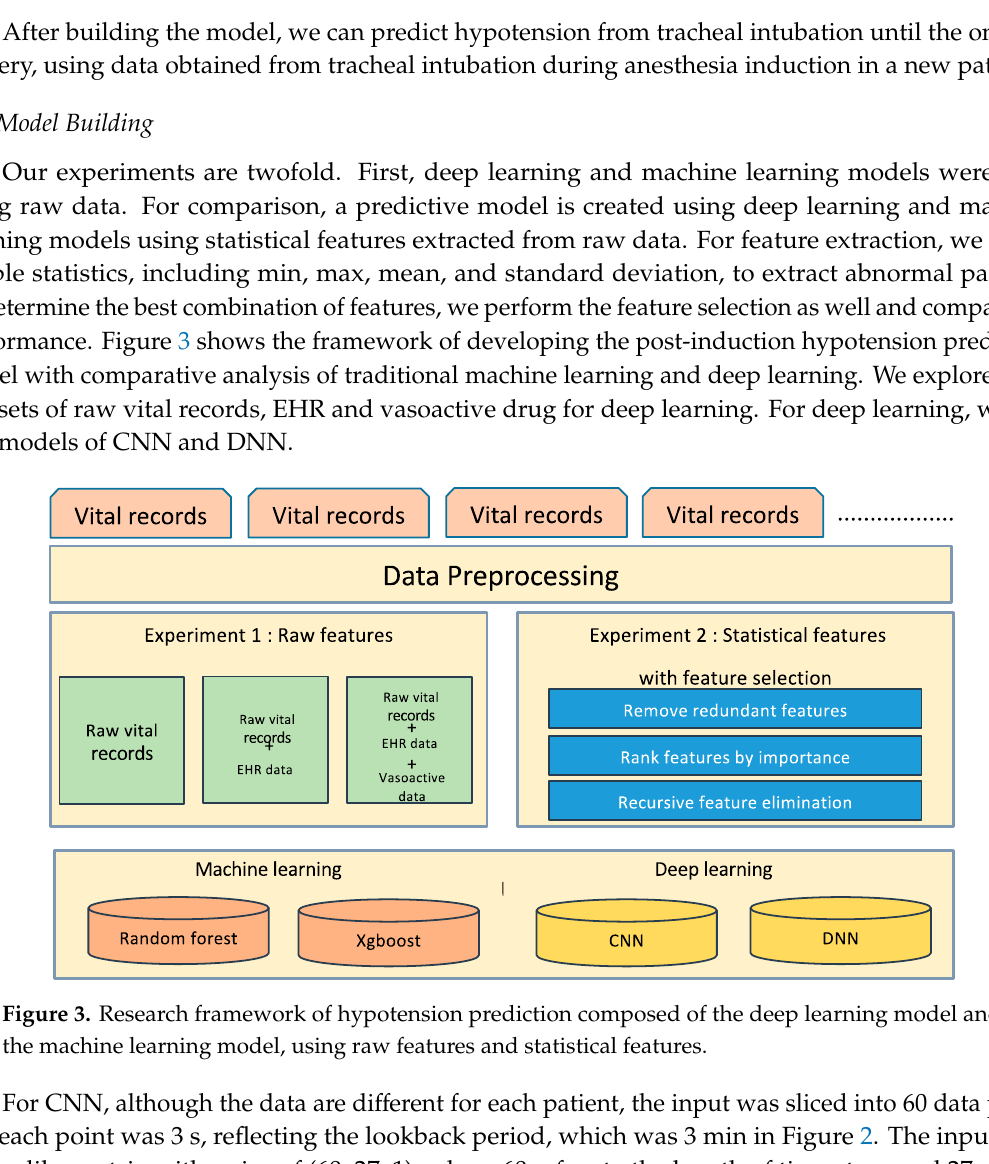
Figure 2. Preparing training data.